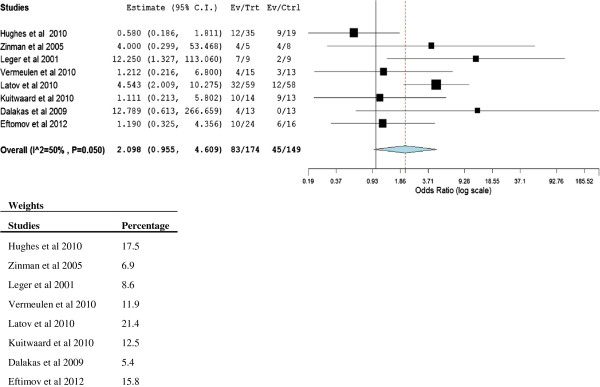
Meta-analysis of studies to improve recovery of CIDP versus control groups. Odds ratios are presented with 95 percent confidence intervals. Overall effect is shown using DerSimonian-Laird (DL) binary random- effect model.